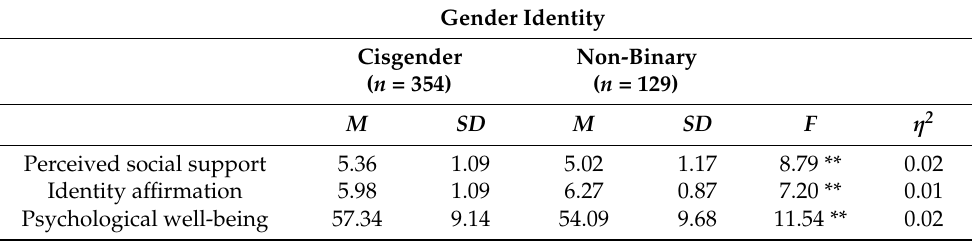
Table 3. Means comparisons of perceived social support, identity affirmation, and psychological well-being based on gender